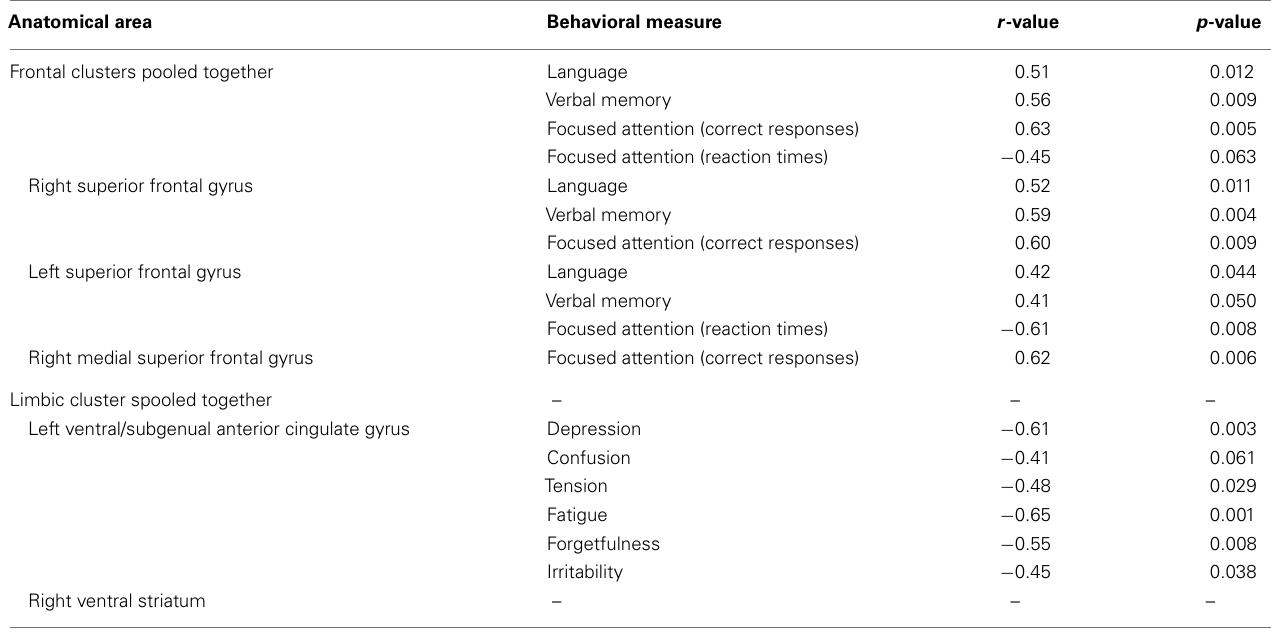
Table 6 | Correlation between GMV increase and behavioral change (6-month − acute) in LHD patients. Anatomical